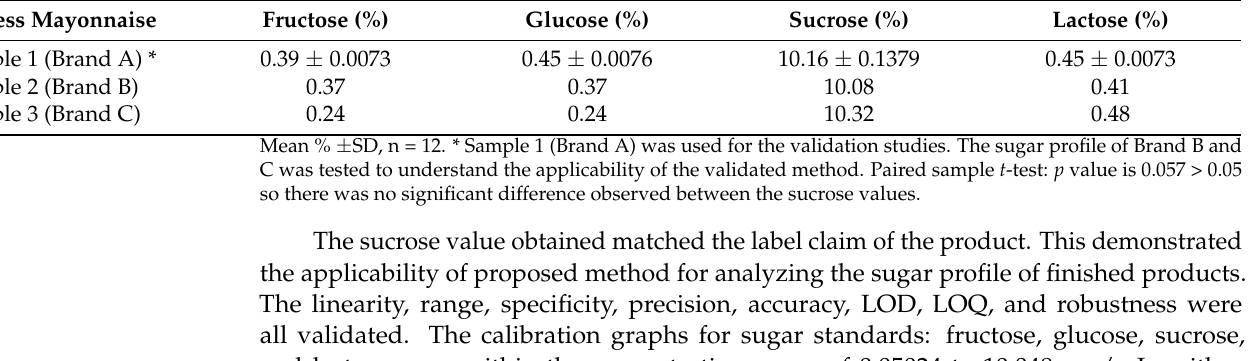
Table 2. Sugar profile of the eggless mayonnaise samples.